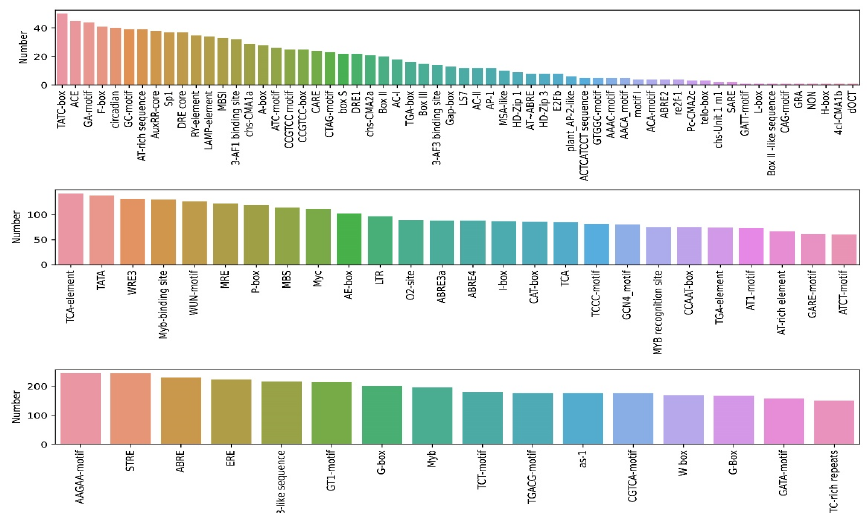
Figure 5. Cis -acting elements of PtrNACs . The cis -regulatory elements of poplar NAC genes were predicted from their 2kb upstream sequences using PlantCARE predicted from their 2kb upstream sequences using PlantCARE database.